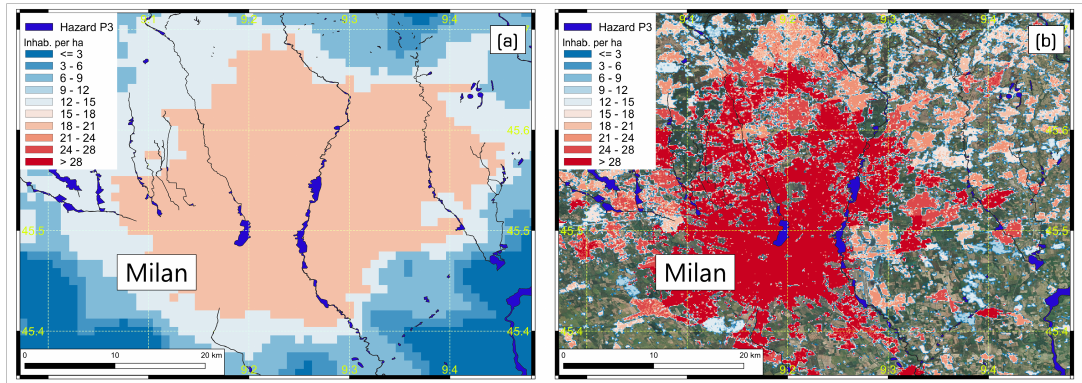
Figure 12. Derived ( a ) and reference ( b ) population distributions for the city of Milan, overlapped by P3 (high probability) hazard zones provided by